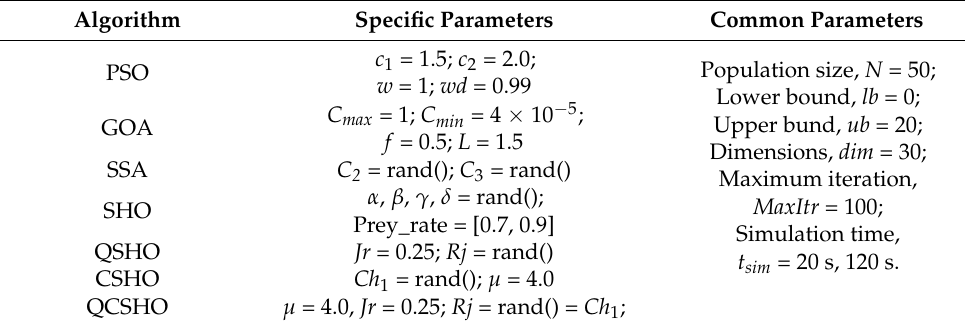
Table 2. Key parameters for corresponding algorithms. Algorithm